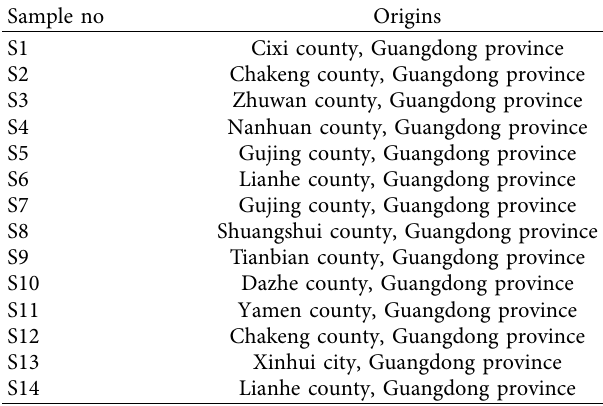
Table 1: Fourteen batches of CRC leaves from diferent areas. Sample